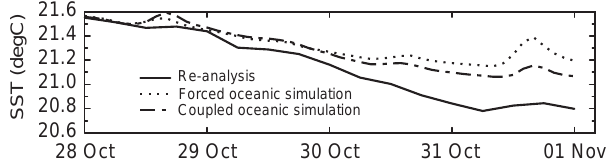
Fig. 5. Evolution of the sea surface temperature from 28 October to 1 November. ARPEGE re-analysis ( solid line ), forced OPA simulation ( dotted line ) and coupled simulation ( dashed line